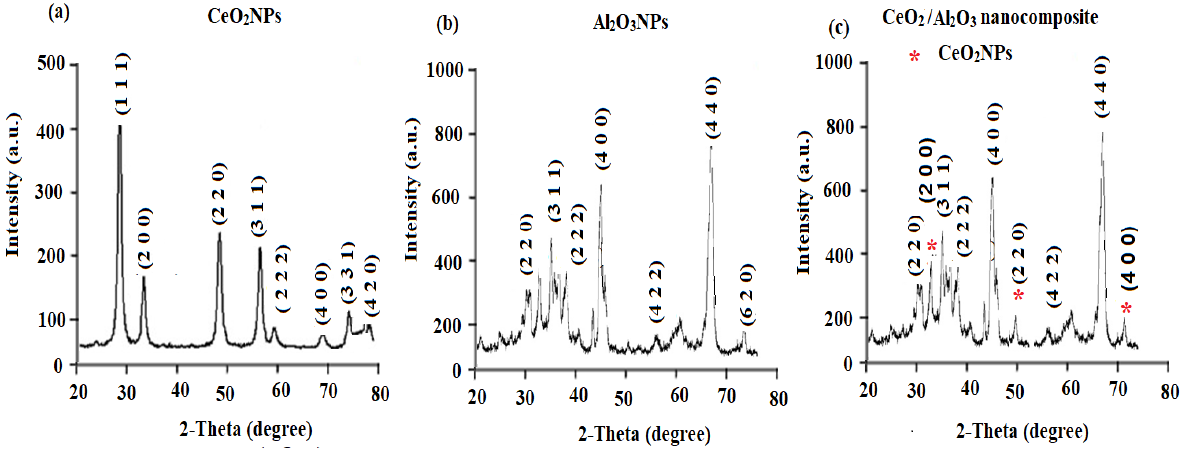
Figure 6. XRD patterns of ( a ) CeO 2 NPs, ( b ) Al 2 O 3 NPs, and ( c ) CeO 2 /Al 2 O 3 nanocomposite measured in the range of 2 θ degree between 20–80°.